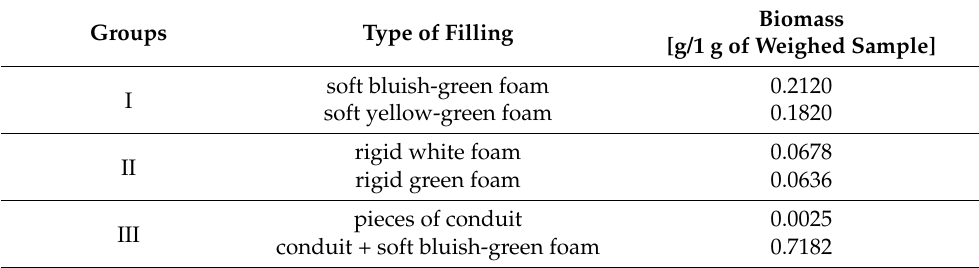
Table 2. Average content of biomass immobilized on waste PUFs from groups I–III after 48 h of batch